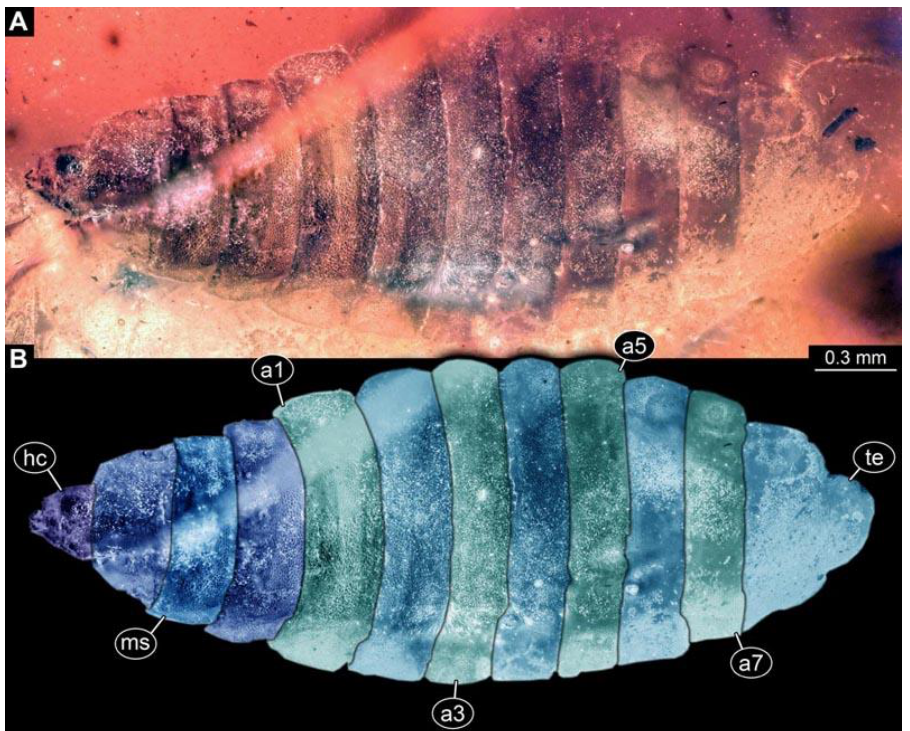
Figure 23. Fossil larva of morphotype 2 or 7, specimen PED 0730. ( A ). Dorsal view. ( B ). Colour- marked. Abbreviations: a1 – a7 = abdomen units 1 – 7; hc = head capsule; ms = mesothorax; te = trunk end. (123) PED 0806: Specimen accessible in dorsal and ventral view, better visible in ven- tral view (Figure 24). Ventral part mostly with bright pigmentation. Surface structure ap- parent. Head capsule well preserved. Ventral spine-like setae well developed. Dimen- sions: body length 5.32 mm, body width 2.05 mm, head capsule length 0.43 mm, head capsule width 0.21